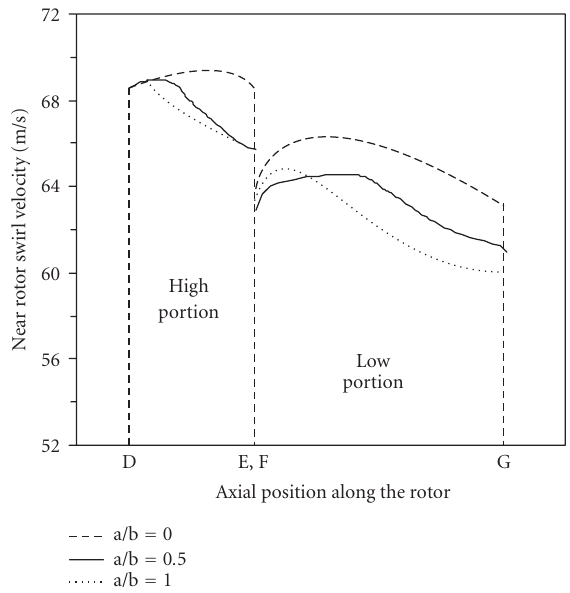
Figure 13: Variation of rotordynamic coe ffi cients with seal leakage (seal inlet swirl = 70m/s; asymptotic swirl ≈ 0 . 6( ωR sh ) = 31 . 2m/s; a/b = 1 .